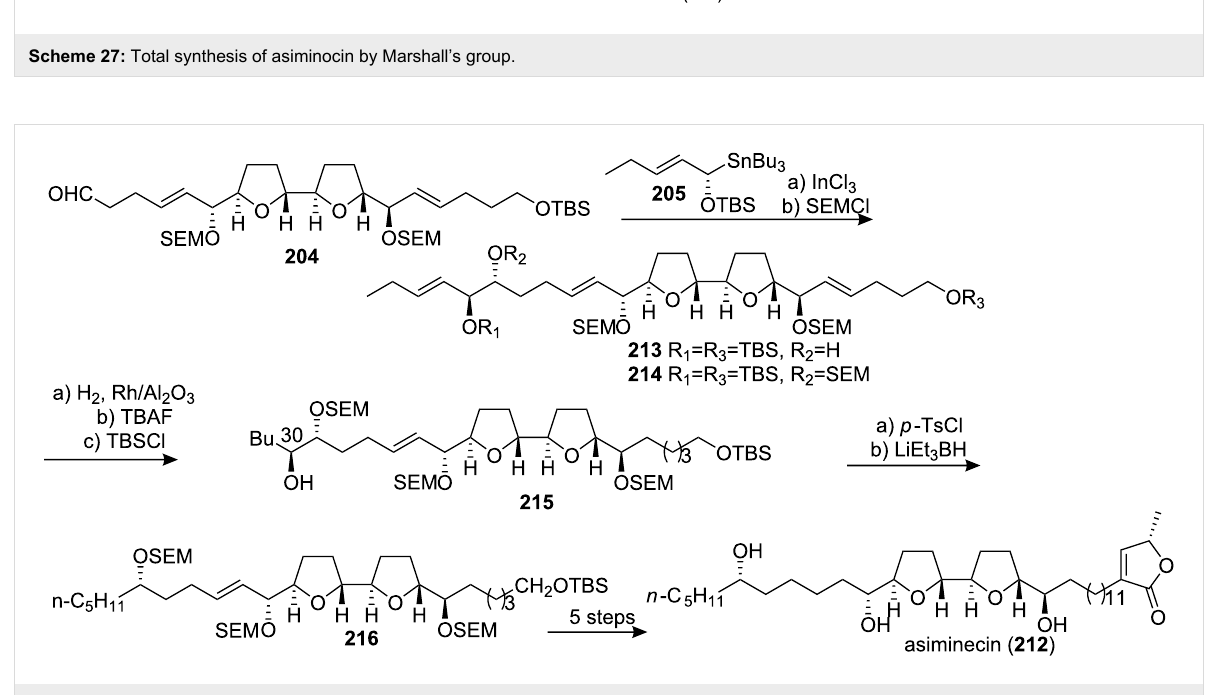
Scheme 28: Total synthesis of asiminecin by Marshall’s